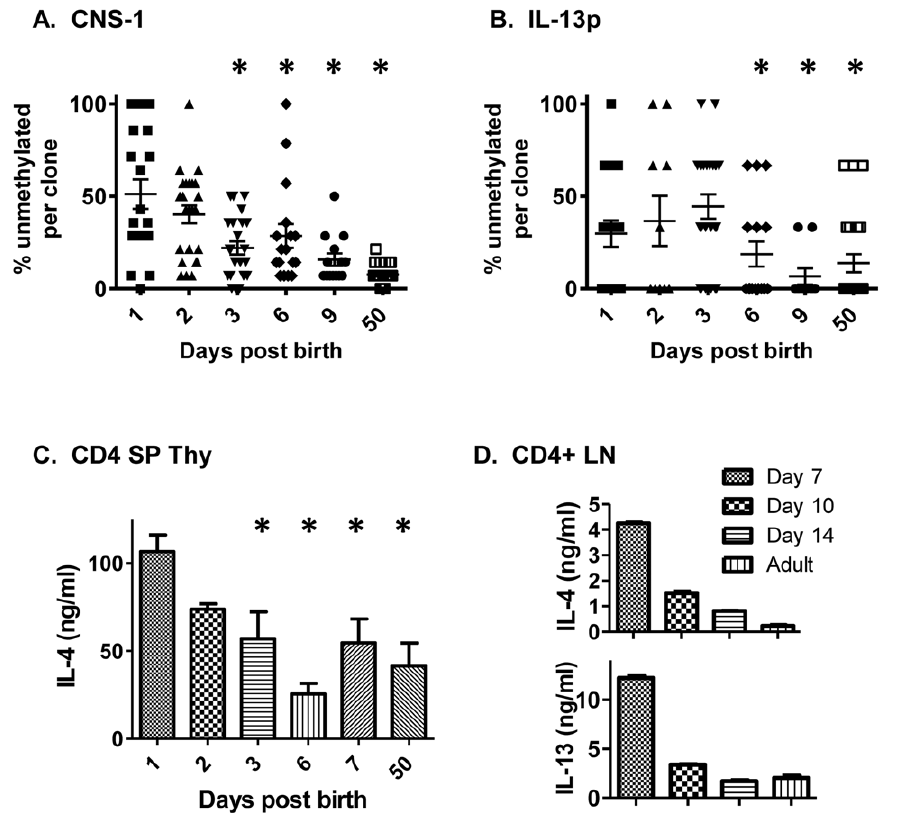
Figure 5. Rapid acquisition of adult-like methylation patterns post birth; association with loss of rapid IL-4 production. Sorted CD4 SP thymocytes were prepared from animals at the indicated days post birth and analyzed by bisulfite sequencing for the methylation status of CNS-1 (A) and IL-13p (B). Data from two independent cellular isolates are shown. Each symbol represents the percentage unmethylated within an individual clone; the averages among all clones are indicated by the horizontal bars. * p # 0.04 by Mann Whitney analyses, relative to day 1; all other comparisons to day 1 are not significant. (C) CD4 SP thymocytes were sort-purified and (D) CD4 + lymph node (LN) cells were prepared by positive selection on Miltenyi columns. Cells were activated for 24 (CD4 SP) or 48 (CD4 + LN) hr with plate bound anti-CD3 and anti-CD28. Supernatants were harvested and tested for IL-4 or IL-13 content using specific ELISA. *p , 0.01 (Students’ t test) compared with day 1 CD4 SP.